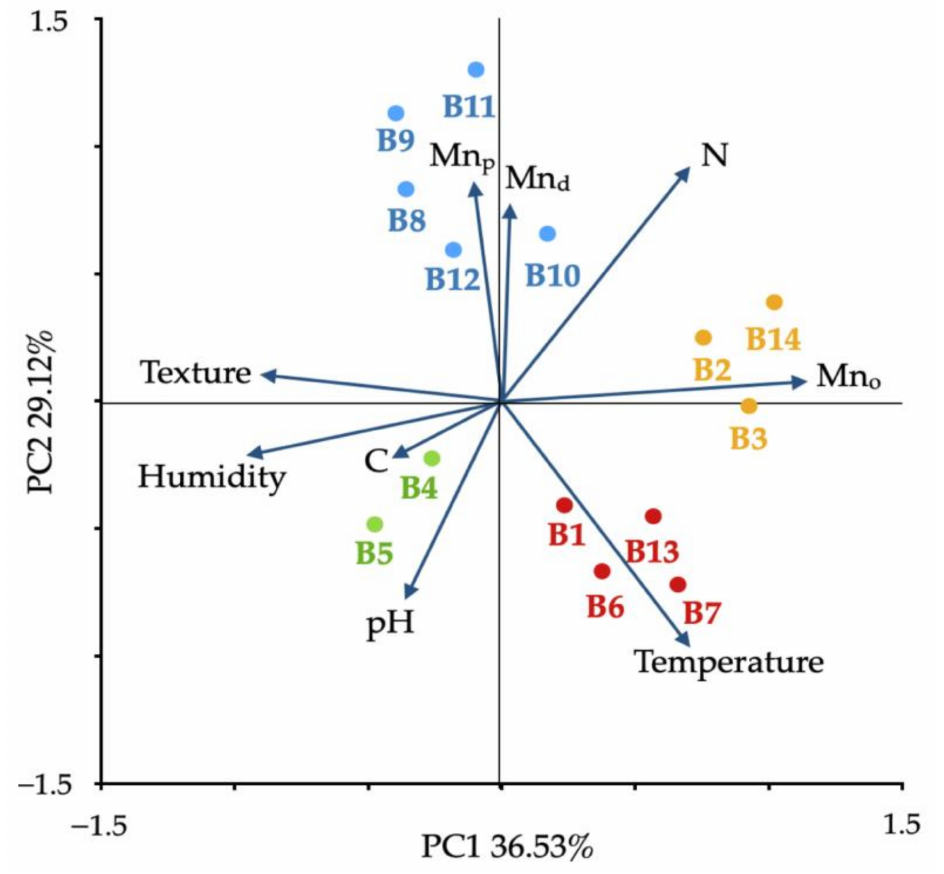
Figure 2. Principal component analysis (PCA) based on soil physicochemical characteristics as